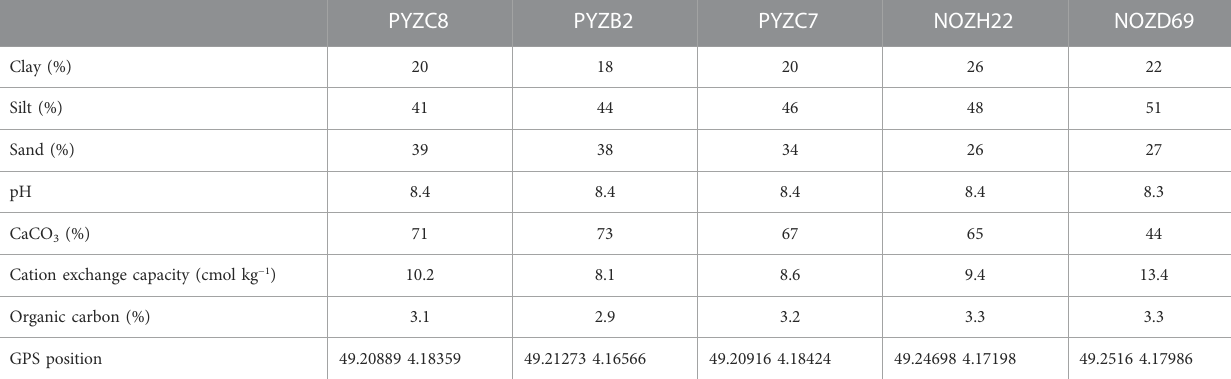
TABLE 3 Physico-chemical characteristics of the sampled soils and GPS localization. Percentages of organic matter and CaCO 3 are expressed as a weight percentage of dry whole solid. Percentages of sand, silt and clay are expressed as weight percentages of dry mineral